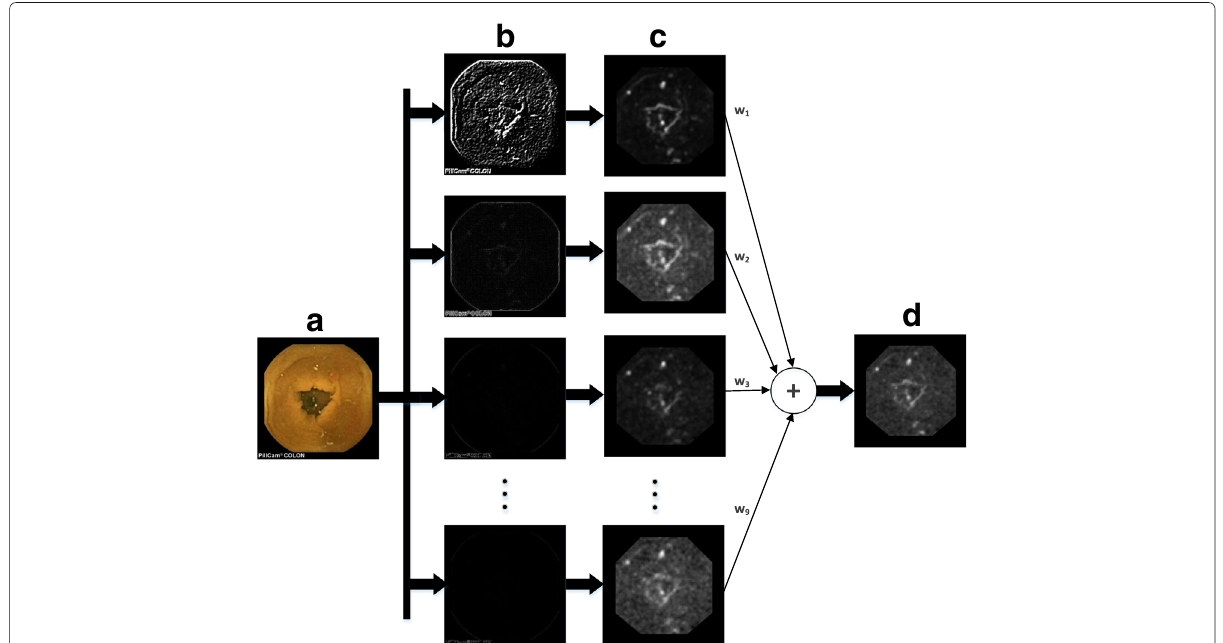
Fig. 1 Image texture computation scheme. Given input image ( a ), nine filter responses ( b ), are computed by applying nine masks as explained in Section 3, then followed by computing energy map at each pixel by summing absolute value of filter output across neighborhood around pixel. The image responses are masked to remove margins containing text and normalized between [0,1], ( c ). Finally, the final texture map ( d ) is estimated using Eq.